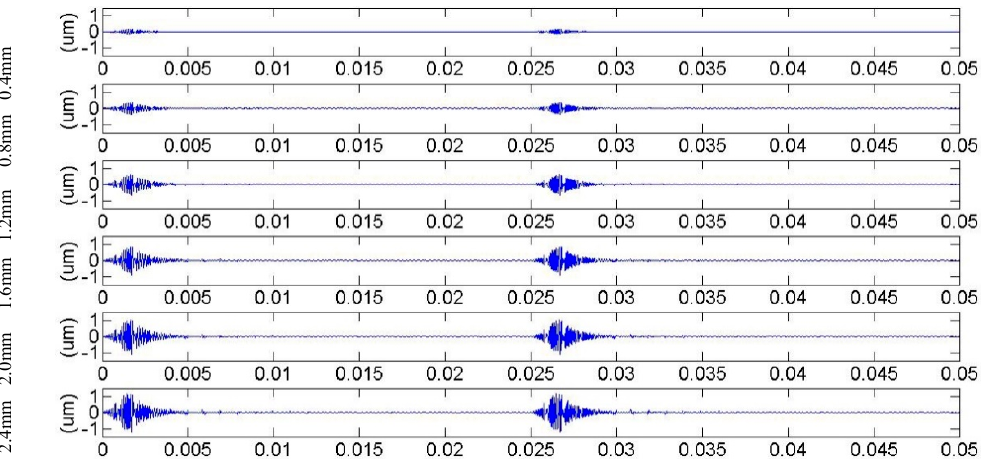
Figure 20. Vibration response for the cracked gear under the 2.5 mm modulus.